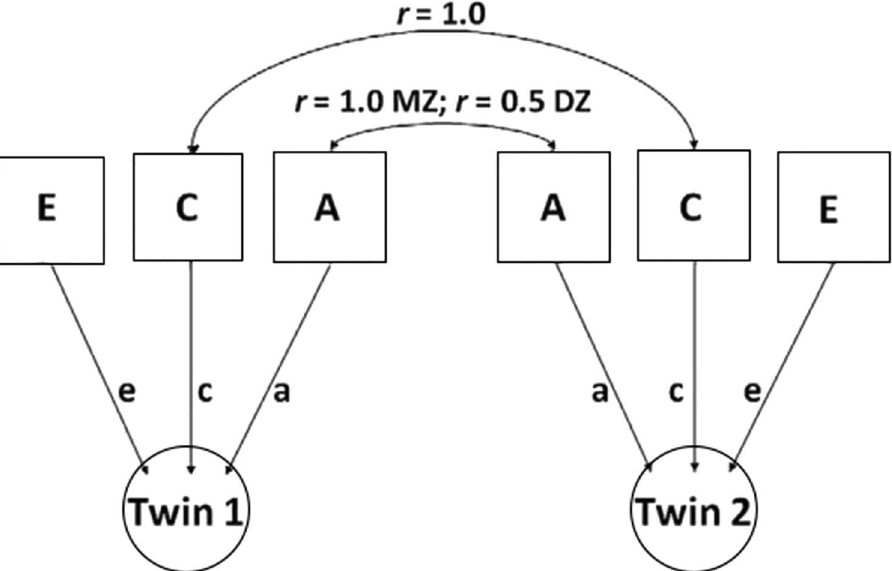
Figure 1. ACE model Univariate ACE model, A: additive genetic effects; C: common environmental effects; E: individual-specific environmental effects; a, c and e: path coefficient of A, C, and E. r: correlation coefficient; MZ: monozytic; DZ: dizygotic; Twin 1: elder one; Twin 2: youngerone.